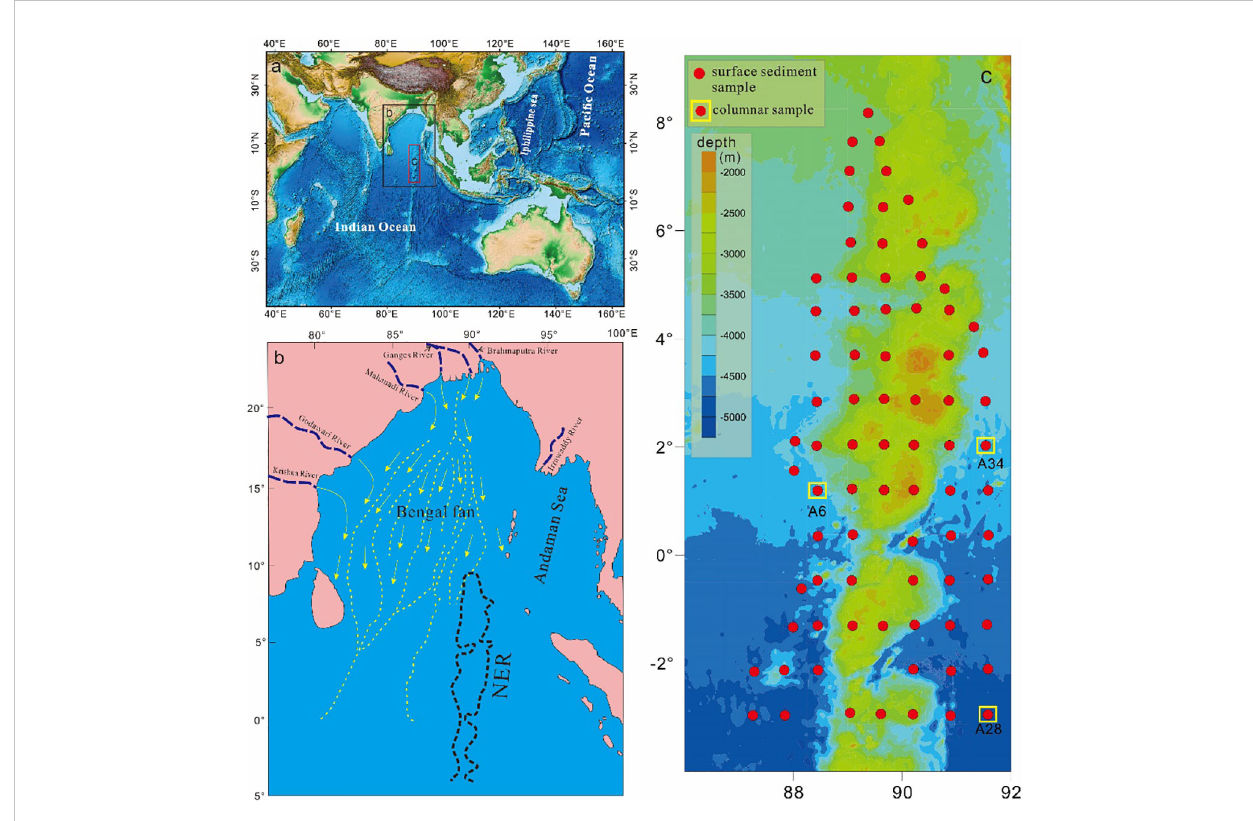
FIGURE 1 Location of the study area (A) , the source material of Bengal fan (B) and sample distribution (C)